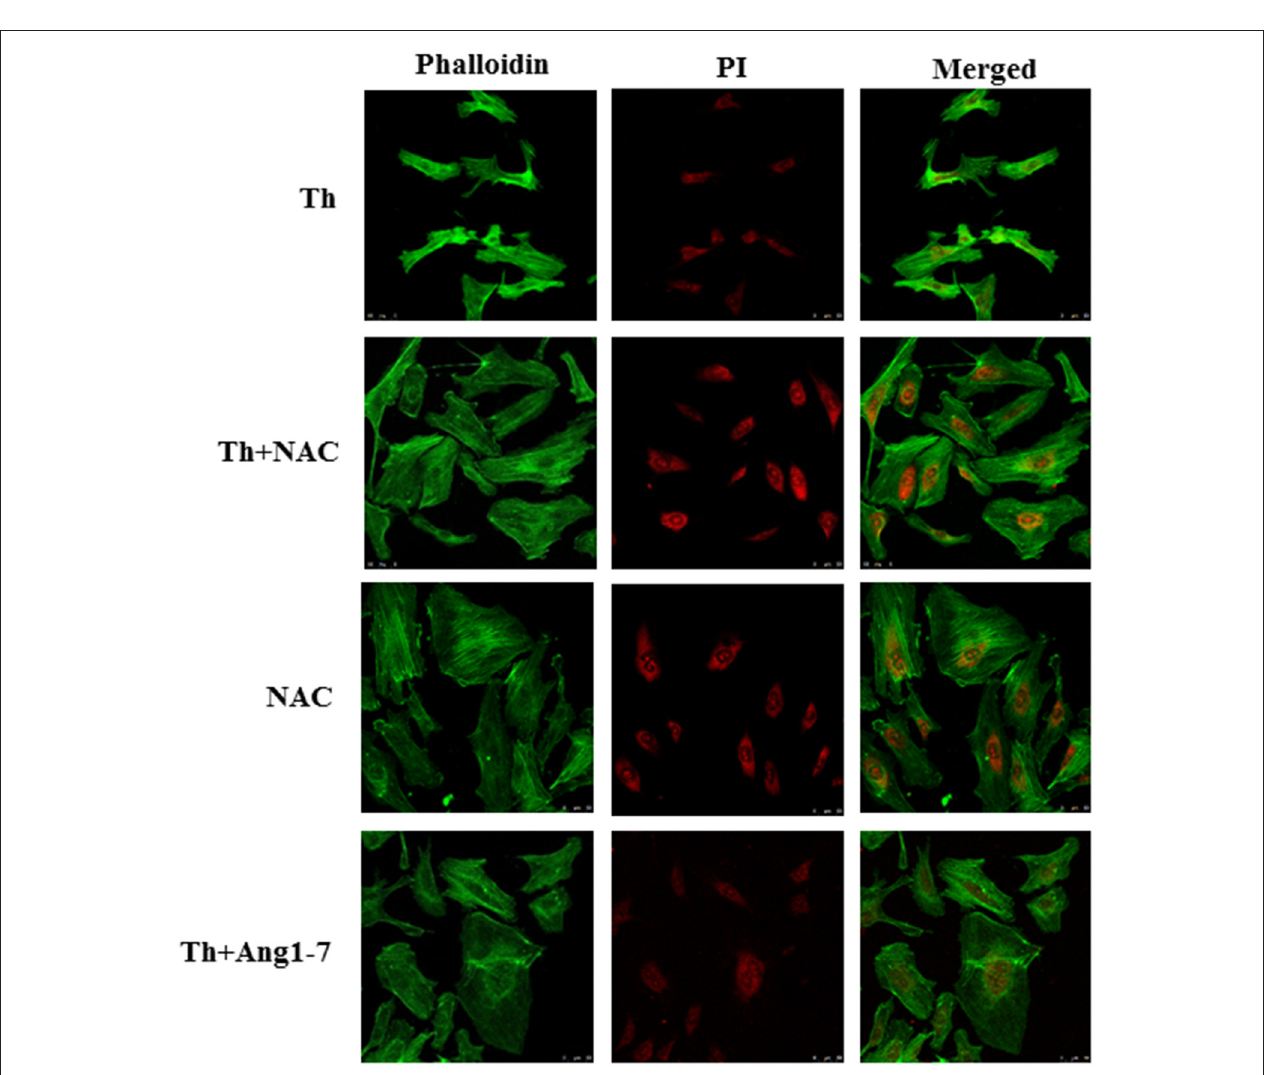
FIGURE 4 | Protective effect of angiotensin-(1-7) on thrombin-induced actin cytoskeleton derangement is ROS-dependent. HAECs were stimulated with thrombin (2 U/mL) for 5h with or without 100nM angiotensin-(1-7) pretreatment 1h before the thrombin stimulation. Cells were pretreated with the ROS scavenger NAC at a dose of 10mM for 1h before thrombin stimulation. NAC pretreatment prevented thrombin-induced actin cytoskeleton abnormalities. NAC, N-acetylcysteine. Images represent results from three independent experiments. Scale bar = 50 µ